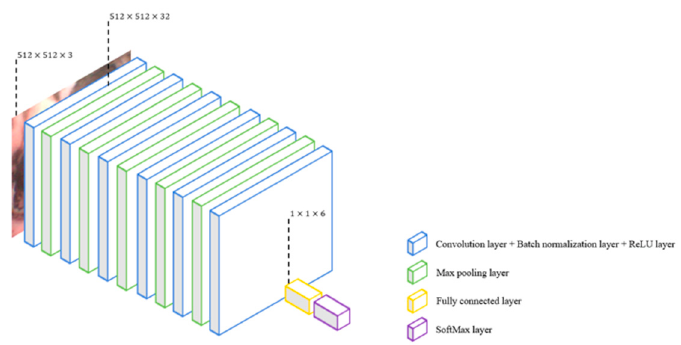
Figure 8. Architecture of CNN-25, which is a typical 25-deep CNN model (includes 6 convolution layers).